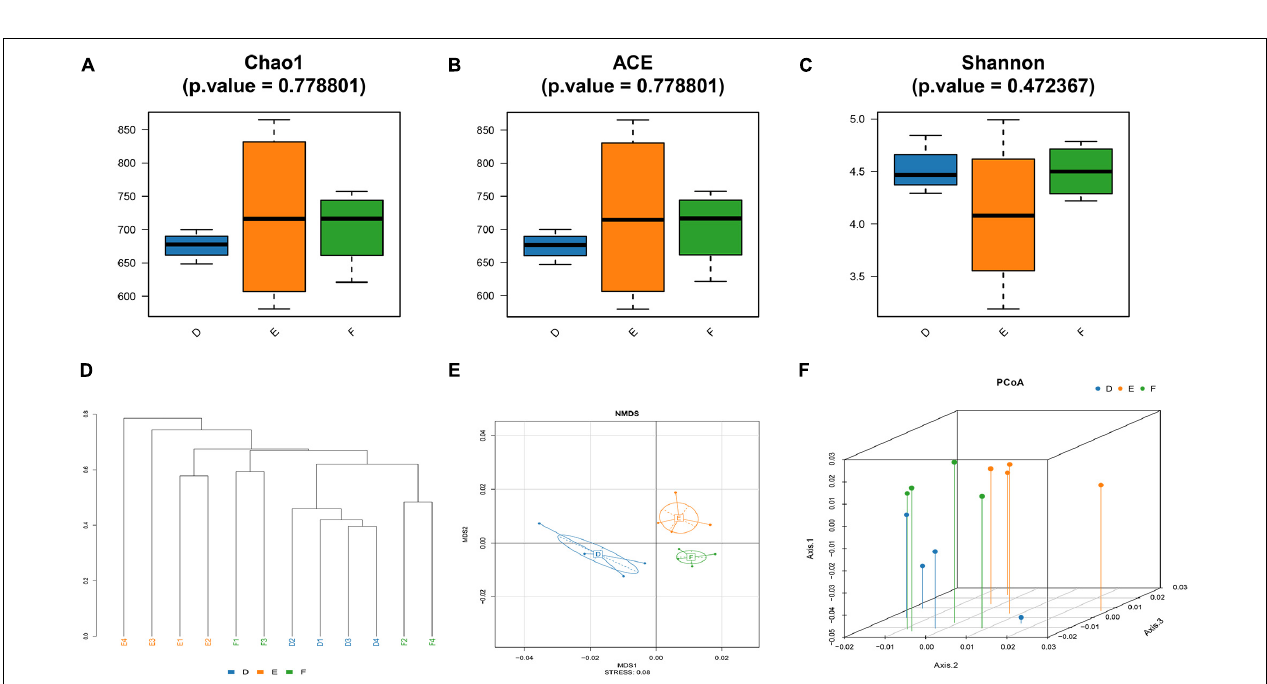
FIGURE 4 | Changes in the diversity of the gut microbiota ( n = 4/group): (A–C) the Chao1 index, ACE index, and Shannon index of three groups; (D) Samples Cluster Tree analysis based on unweighted pair group method with arithmetic mean method; (E) non-metric multidimensional scaling method (NMDS) is to simplify the research objects (samples or variables) in multidimensional space to low-dimensional space for positioning, analysis, and classification. (F) Principal coordinates analysis (PCoA).